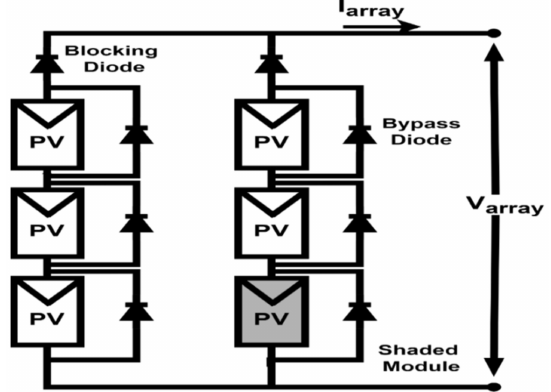
Figure 4. PV Array under Partial Shading